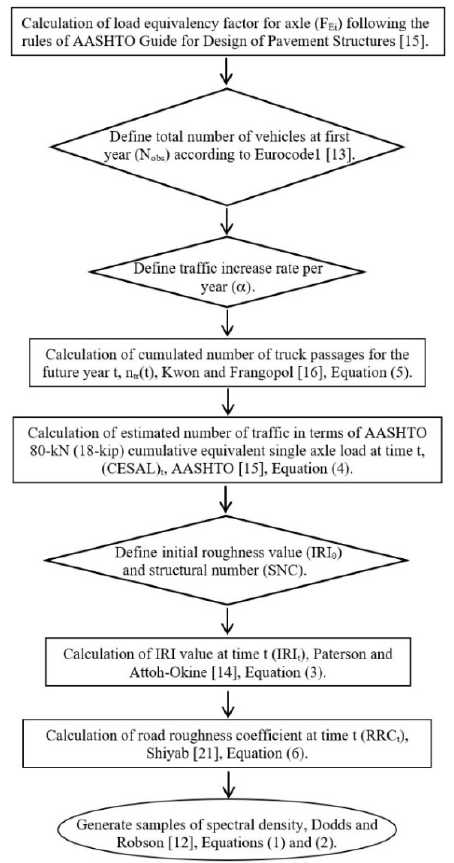
Figure 2. General flowchart used for the pavement progressive deterioration